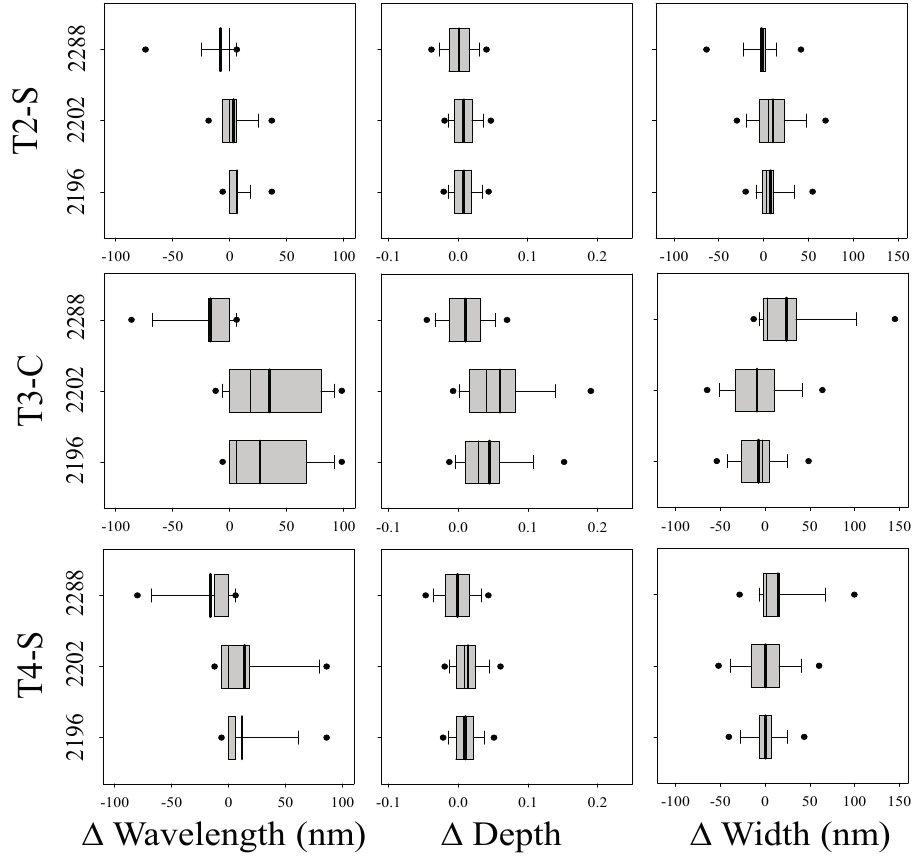
Figure 6. Changes (differences) in the feature parameters wavelength position, depth and width for images T2-S, T3-C and T4-S, relative to image T1-S. Positive and negative values indicate that the parameter in question is larger or smaller than the image T1-S. Zero values indicate no change. Graphical elements of the box-plots describe various statistical attributes of the data: box boundaries (25th and 75th percentiles); thin and bold lines bisecting box (median and mean of data, respectively), whiskers (10th and 90th percentiles), filled circles (5th and 95th percentiles of the